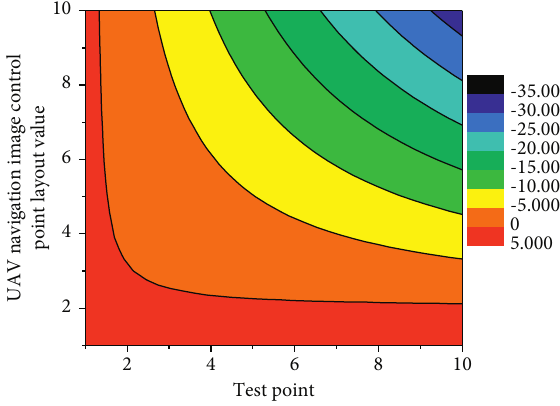
Figure 7: Layout of drone navigation image control